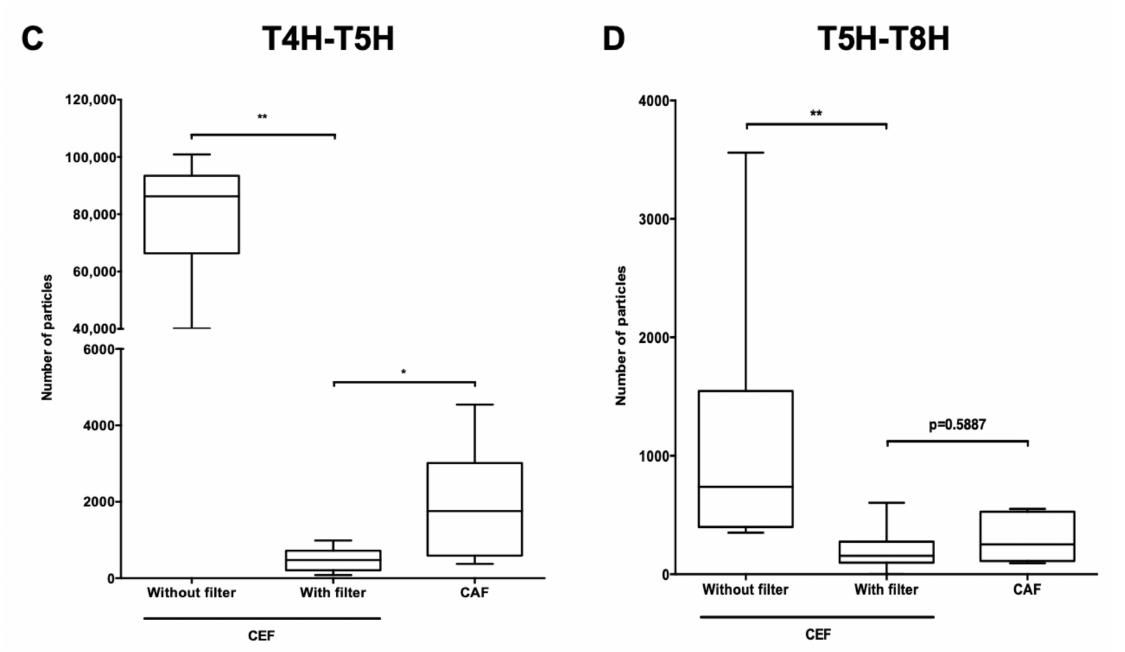
Figure 8. Impact of filter on the emergency route of the CEF infusion line. Comparison of total particulate load between a CEF infusion line without filter and a CEF infusion line with filter and a CAF infusion line at times T0-T8H ( A ); T0-T4H ( B ); T4H-T5H ( C ); T5H-T8H ( D ). CEF without filter: infusion line with unfiltered cefepime on emergency route; CEF with filter: infusion line with filtered cefepime on emergency route; CAF: infusion line with caffeine on emergency route. Results are expressed as medians [min; max] (**: p < 0.01, *: p < 0.05, Mann Whitney, p < 0.05, n = 6).